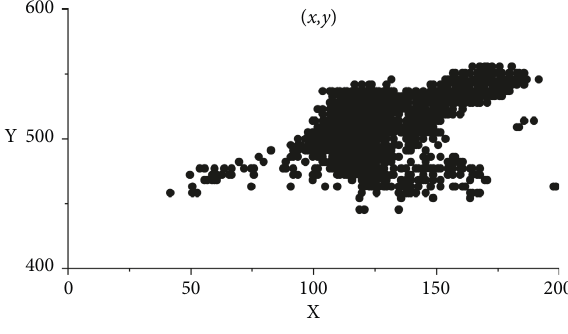
Figure 6: Wrist coordinate distribution.